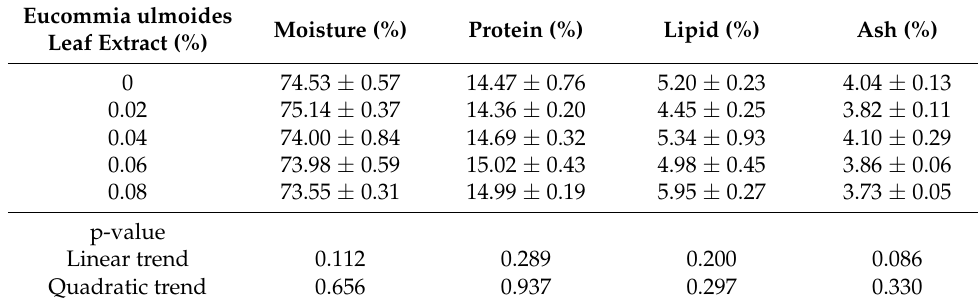
Table 5. Whole-body composition of the GIFT fed with different diets.